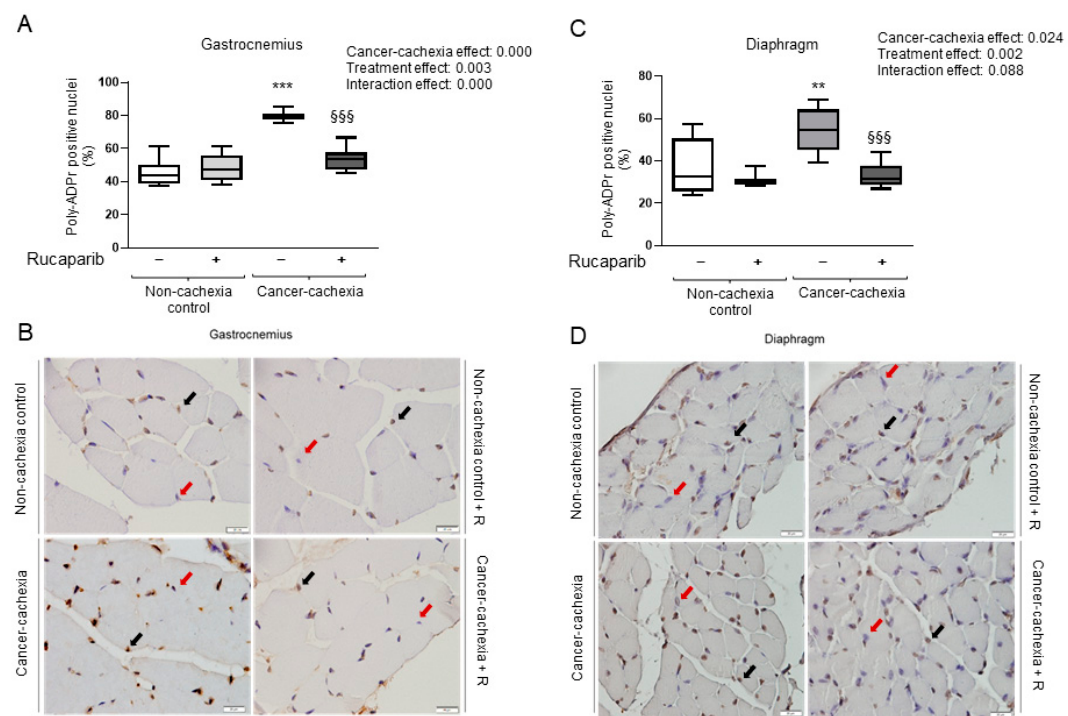
Figure 2. Box plot representation of PARP activity measured as the percentage of positively stained nuclei for poly-ADPr in the gastrocnemius ( A ) and diaphragm ( C ). Representative images of nuclei positively stained for poly-ADPr (black arrows point toward brown nuclei) and not stained (red arrows point toward blue nuclei, hematoxylin counterstaining) in the gastrocnemius ( B ) and diaphragm ( D ) of the different experimental groups of mice. Abbreviations: poly-ADPr, poly-ADP ri- bosylation; − , untreated with rucaparib; +, treated with rucaparib. Statistical significance: ** p ≤ 0.01, and *** p ≤ 0.001 between the untreated non-cachexia controls and the non-treated cancer cachexia mice; §§§ p ≤ 0.001 between the cancer cachexia mice treated with rucaparib and the non-treated cancer cachexia mice. Two-way ANOVA significance ( p value) of cancer cachexia and treatment and interaction effects are also shown for each variable.